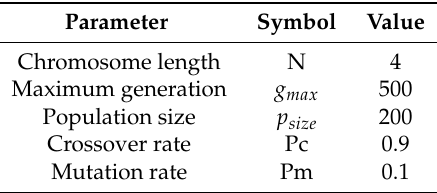
Table 2. Control Parameters of